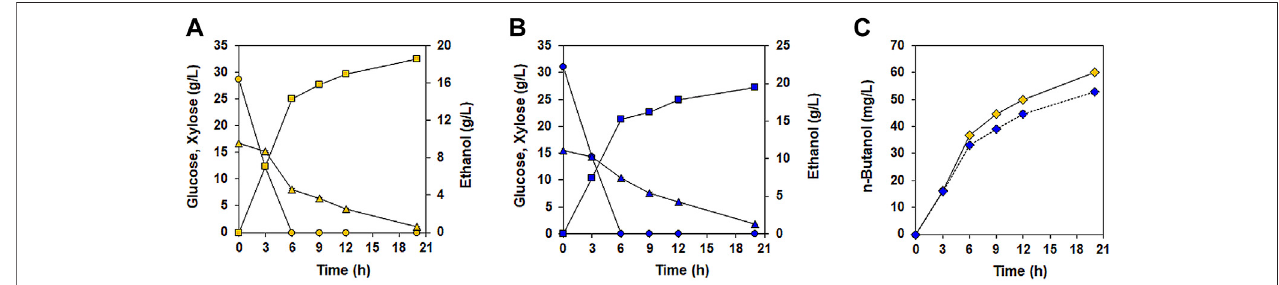
FIGURE 6 | n-butanol fermentation by the XUSAEA-B strain using lignocellulosic hydrolysates. Fermentation was conducted with Miscanthus hydrolysates pretreated with diluted acids. Fermentation with YSC medium composed of the same concentration of sugars (30 g/L of glucose and 15 g/L of xylose) was also conductedunderthesameconditions.TheinitialODandpHwere15and6.5,respectively. (A) Fermentationperformanceusinglignocellulosichydrolysates(yellow). (B) Fermentation performance using YSC medium (blue). (C) n-butanol production during fermentation using lignocellulosic hydrolysates (solid line, yellow diamond) and synthetic medium (dash line, blue diamond). Ethanol production (squares) and glucose (circles) and xylose (triangles) consumptions were measured during fermentation. The error bars represent standard deviations obtained using biological